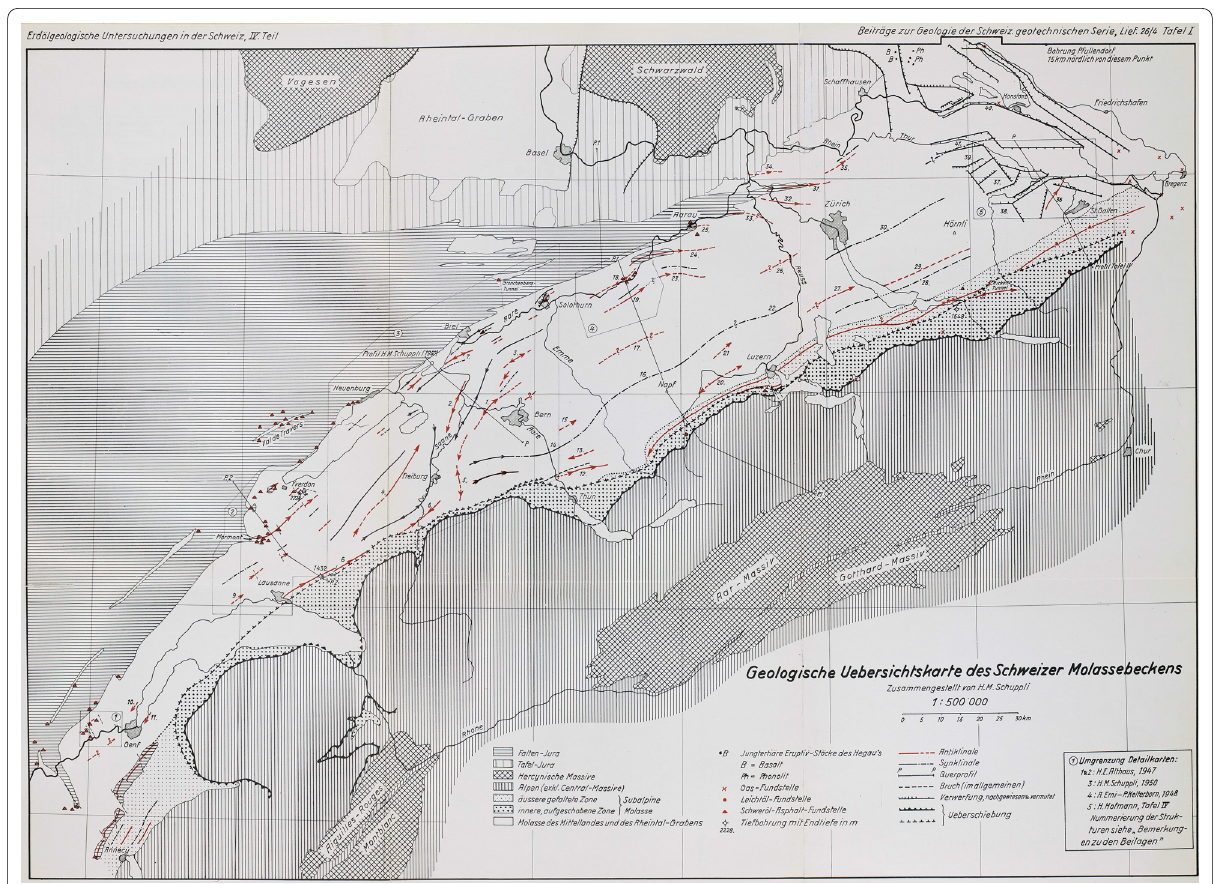
Fig. 14 Overview map of the Swiss Molasse Basin with its main structural features (reproduced from Schuppli, 1952). Red line : anticline, dark blue line : syncline, black line : fault, red cross : gas seep, red circle : light oil occurrence, red triangle : heavy oil or asphalt occurrence. Note the relatively high concentration of oil and asphalt findings along the southern edge of the Jura fold-and-thrust belt in western Switzerland, and the gas shows in the Subalpine Molasse along anticlines and fault traps at the southeastern end of Lake